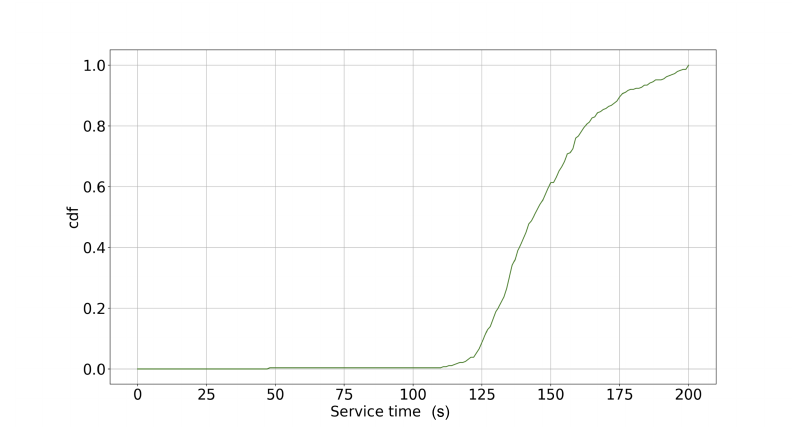
Figure 13. Service time cdf, G ( x ) .